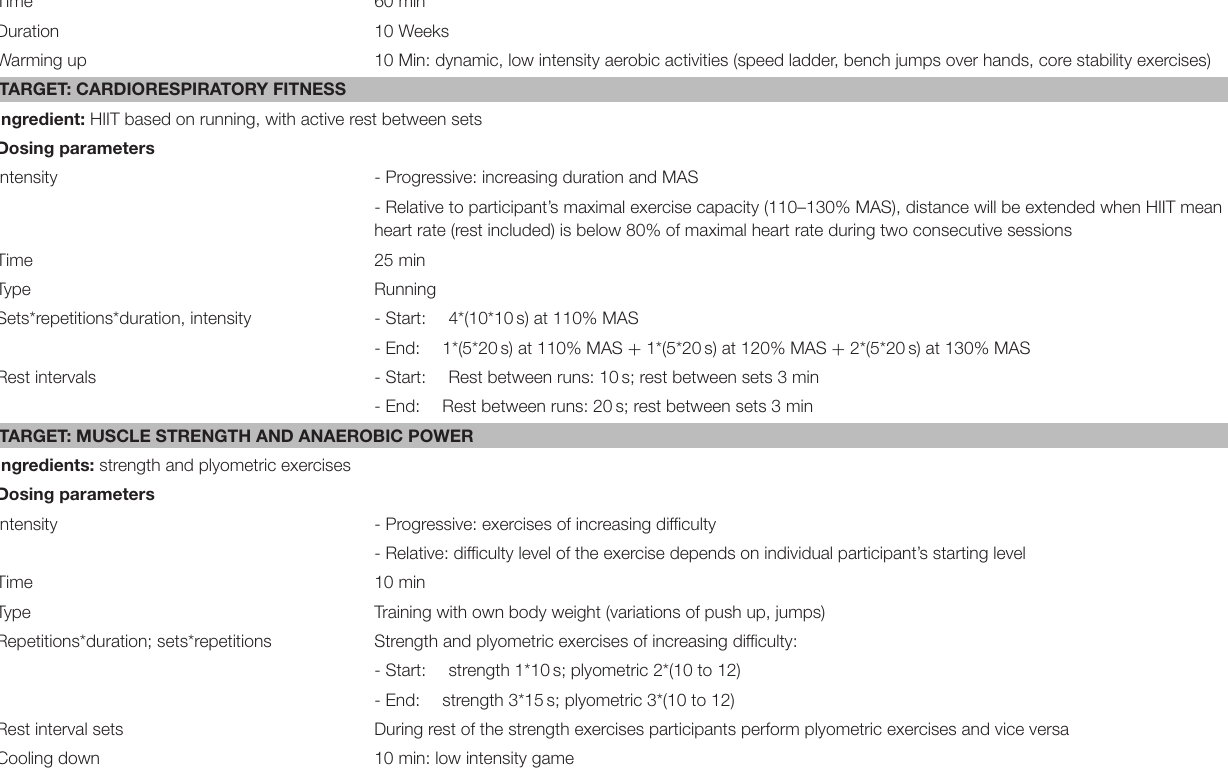
TABLE 1 | Targets, ingredients, and corresponding dosing parameters of We12BFit!-PF. OVERALL Frequency Time Duration Warming